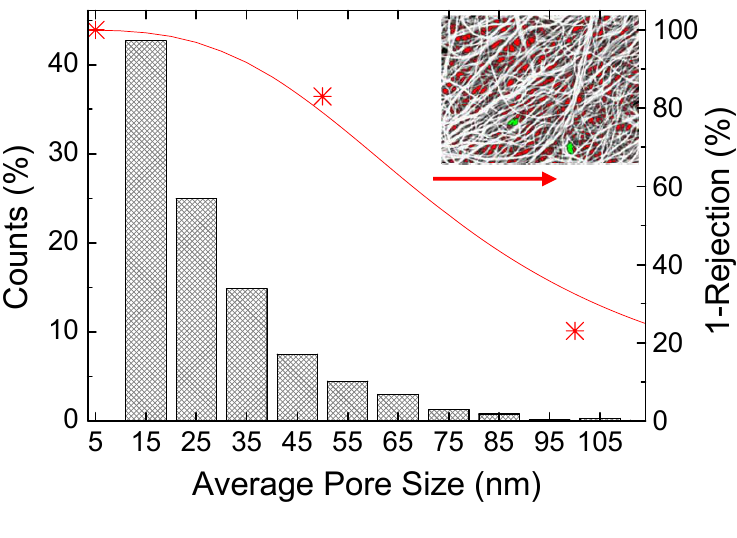
Figure 4. (Histogram - left axis): Average pore size distribution determined by SEM imaging of a Bucky-paper. (Red stars – right axis): Particle rejection tests with polystyrene